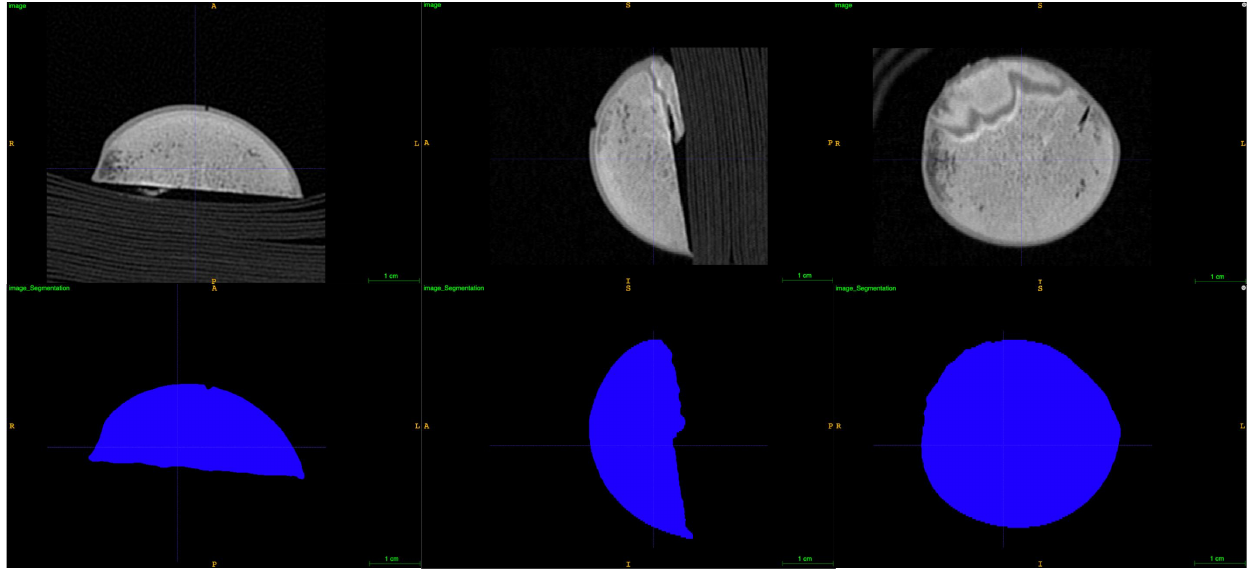
Figure 3. Illustration of computed tomography (CT) scans and segmentations used to determine volume of the excised humeral head.